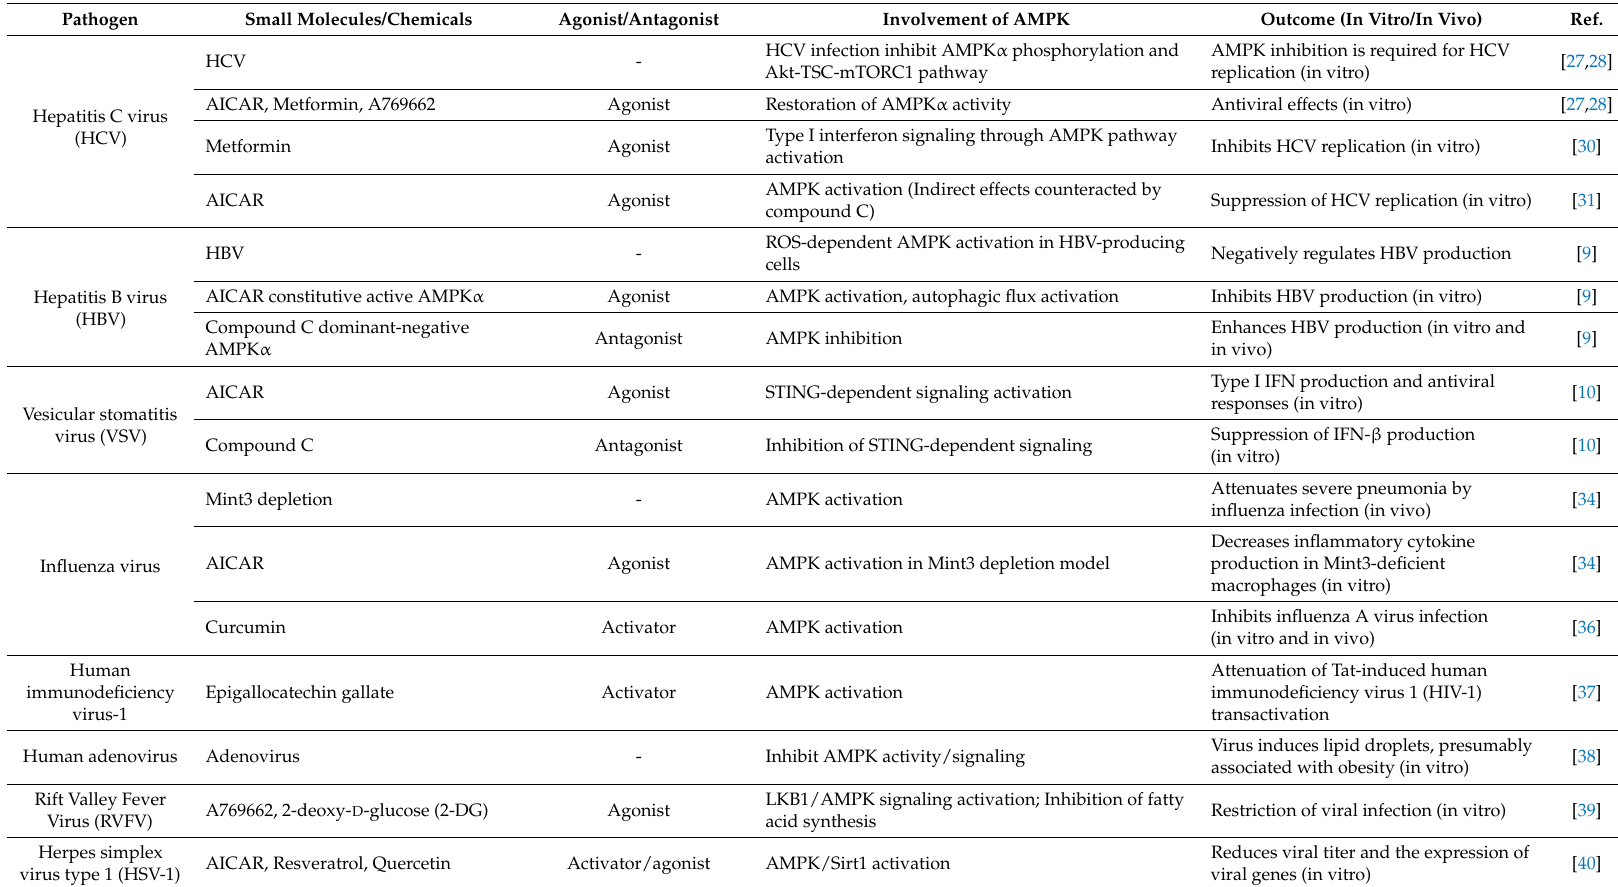
Table 1. Beneficial Effects of AMPK in viral